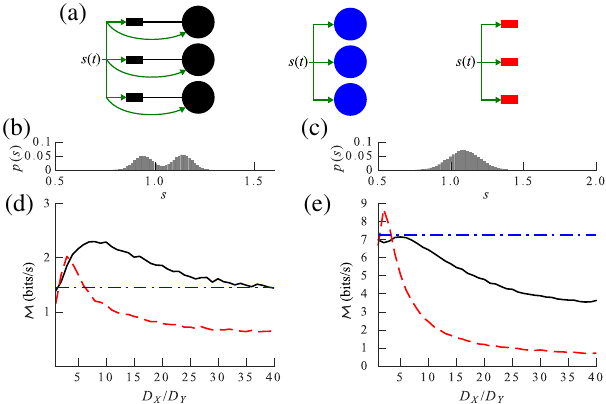
FIG. 4. Stochastic resonance for bimodal input distributions. (a) Schema illustrating a neural ensemble made of dendrite-soma systems (black), somatic units alone (blue), or dendritic unit alone (red). Input distribution for (b) the JDP and (c) a GP with mean matched to that of the JDP. (d) For the JDP, M calculated from the summed activity of 8000 coupled units (black line) surpasses that of isolated Y -unit compartments (blue dot-dashed line) and of isolated dendritic compartments (red dashed line) for a broad range of dendritic noise. (e) The resonance for a GP is reduced with respect to the resonance of obtained using the JDP (d). We use τ ¼ 10 ms to represent M in bits per second; see [36] for all other parameters. [dash-dotted line in Figs. 4(d) and 4(e)]. This stochastic